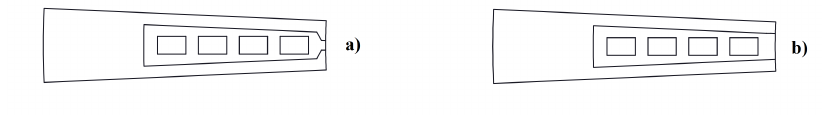
Figure 11. Trapezoidal slot with the narrowest ( a ) and the widest slot opening ( b ).